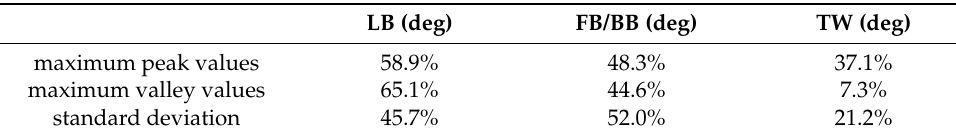
Figure 6. Performance of all the participants for sessions 1, 2, and 3. ( a ) Lateral bending, ( b ) forward/backward bending, and ( c ) twisting. Table 4. Improvement percentage session 1–session 2.